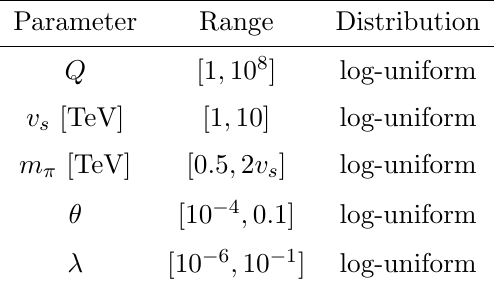
Table 1 . Scan parameters and their ranges. Log-uniform means uniformly distributed on a loga- rithmic scale.